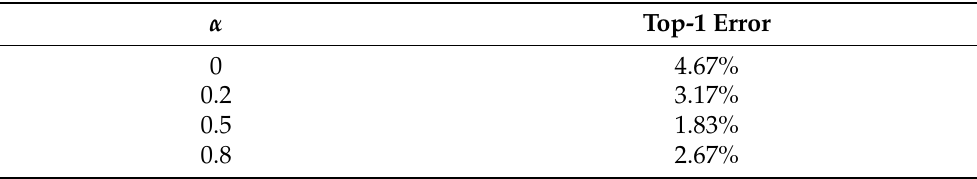
Table 5. Comparison of different α ; 0 means no Gabor loss.